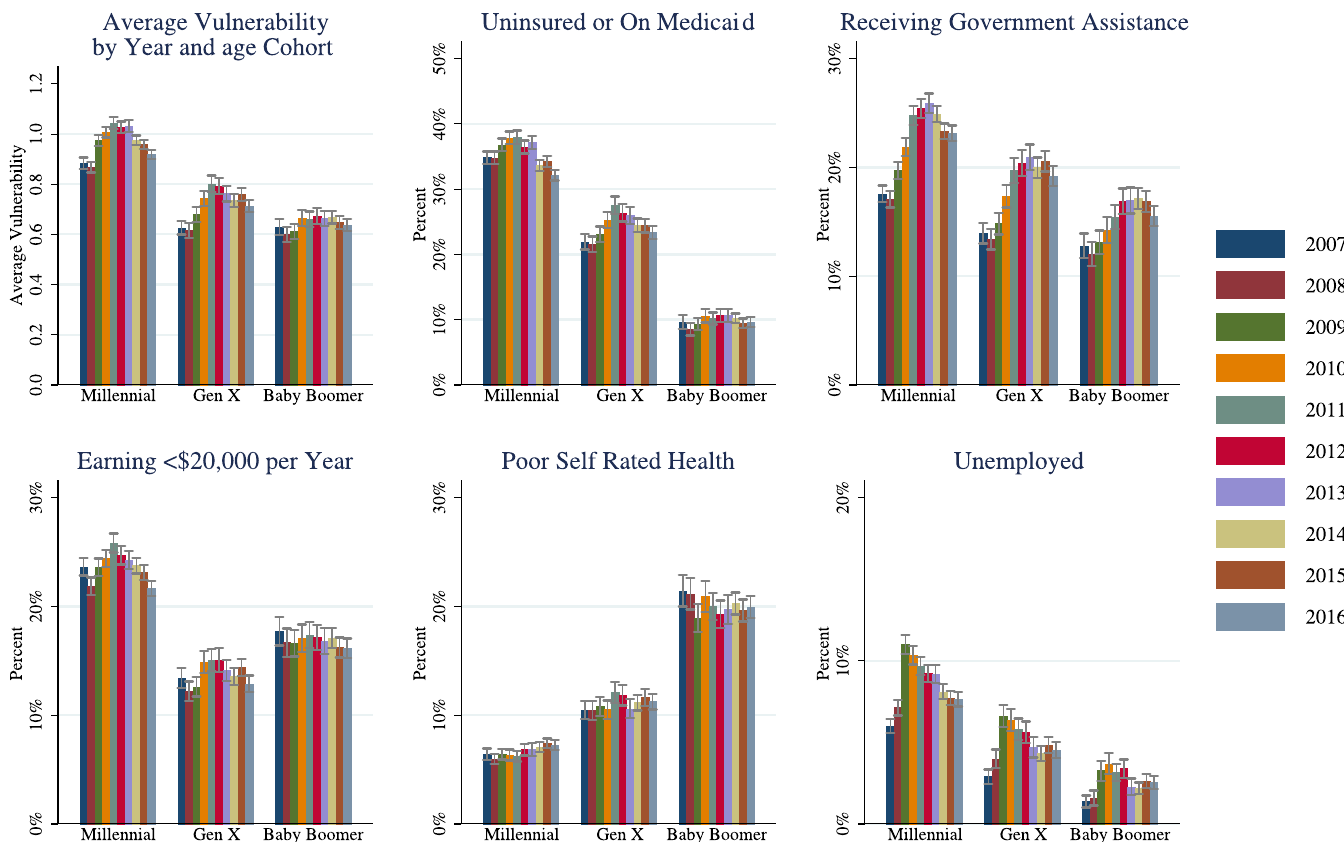
Fig 2. Patterns in social and economic vulnerability by generational cohort, 2007–16. Error bars denote 95% confidence intervals.